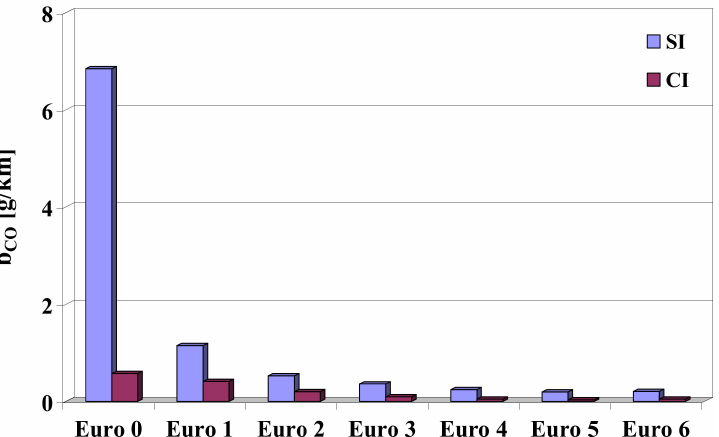
Figure 12. Specific distance emission of carbon monoxide—b CO , from hot passenger car engines of Euro 0–Euro 6 pollutant emission categories, spark-ignition engines—SI and compression-ignition engines—CI, under the model vehicle traffic conditions.